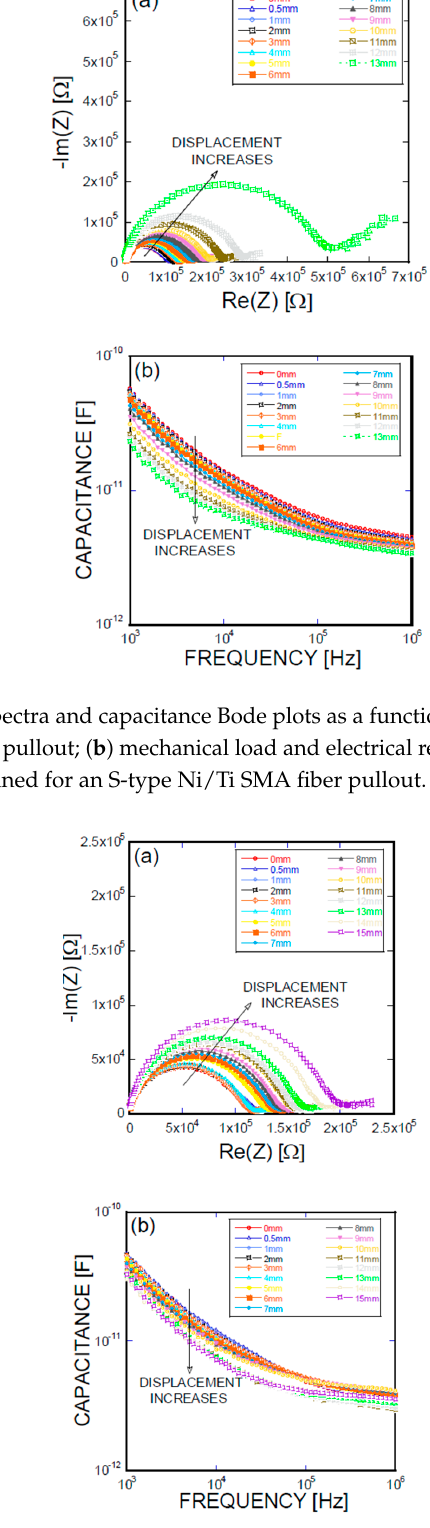
Figure 6. ( a ) Impedance spectra and capacitance Bode plots as a function of displacement obtained for an L-type Ni/Ti SMA fiber pullout; ( b ) mechanical load and electrical resistance extracted as a function of wire displacement obtained for an L-type Ni/Ti SMA fiber pullout.